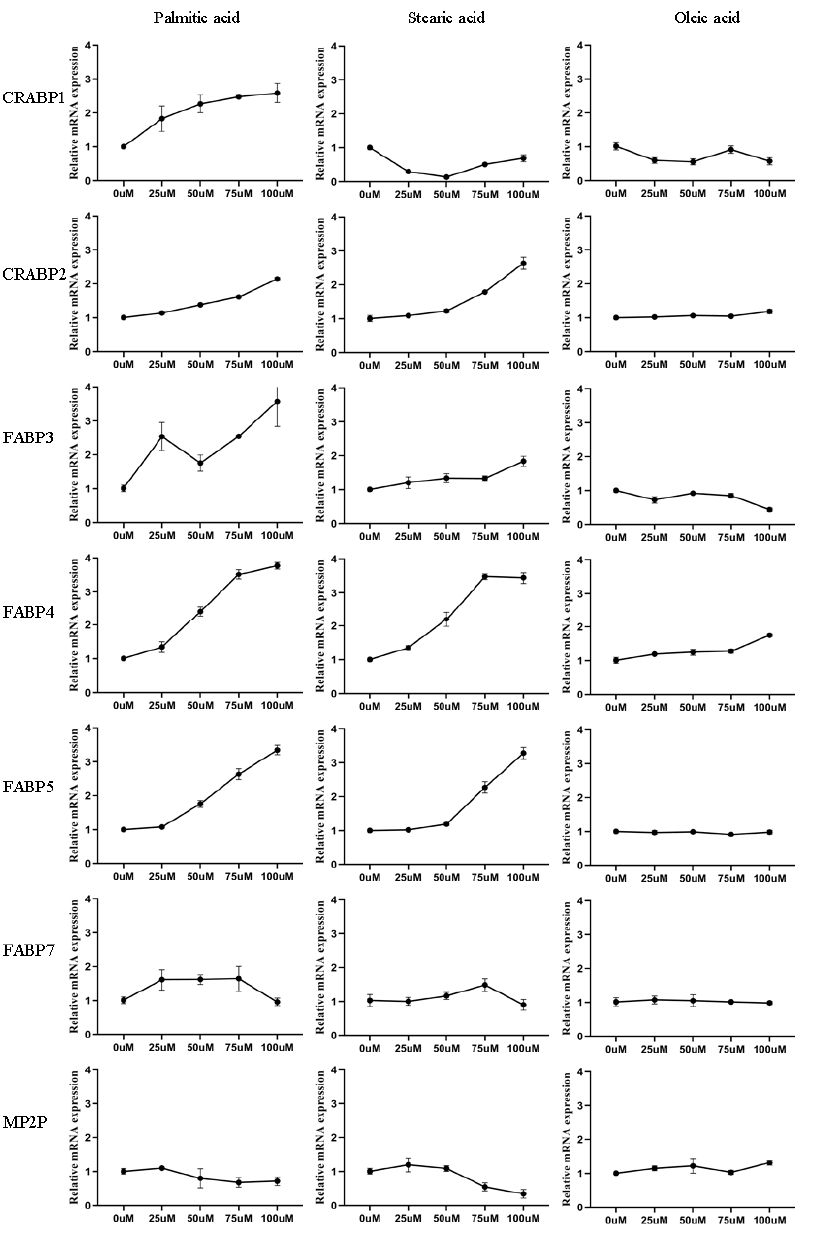
Figure 4. Relative mRNA levels of FABPs in buffalo mammary gland epithelial cells at 24 h after adding palmitic acid, stearic acid, or oleic acid (0, 50, 75, 100, 125, 150 μ M), respectively.